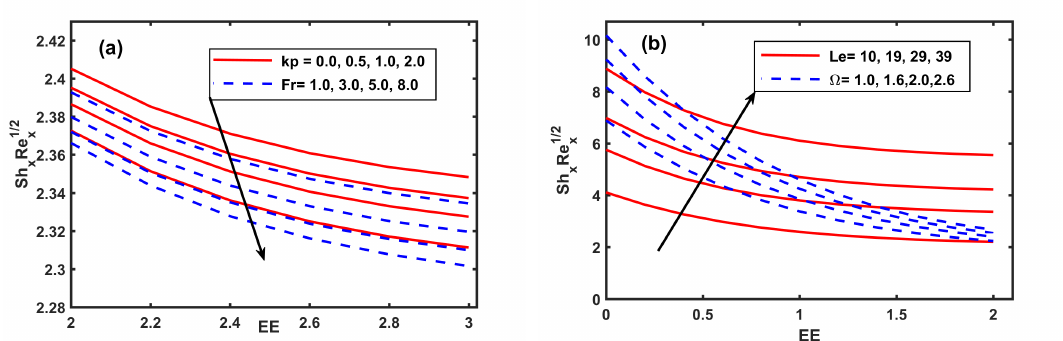
Figure 13. Fluctuation of Sh x Re 1/2 x along with Kp, Fr, EE, Le, and Ω